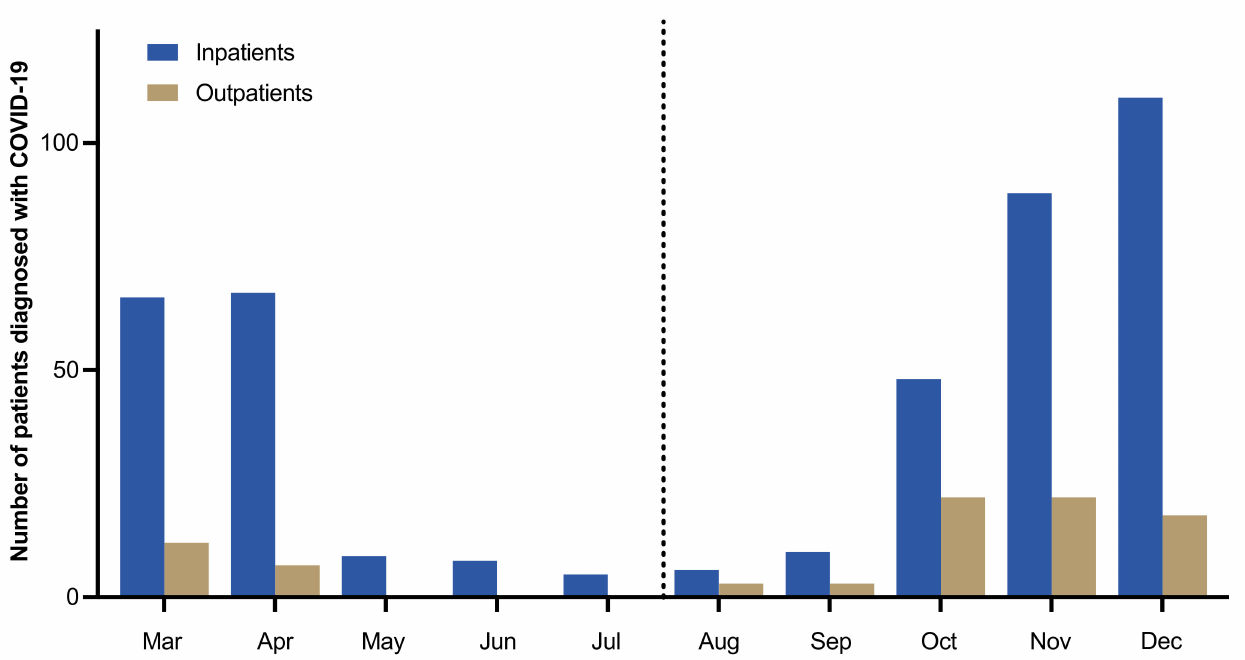
Figure 1. The numbers of COVID-19 patients newly admitted to our hospital or seen as outpatients in our emergency department are listed for each month. The dotted line represents the border between the first and the second wave (29 July 2020).